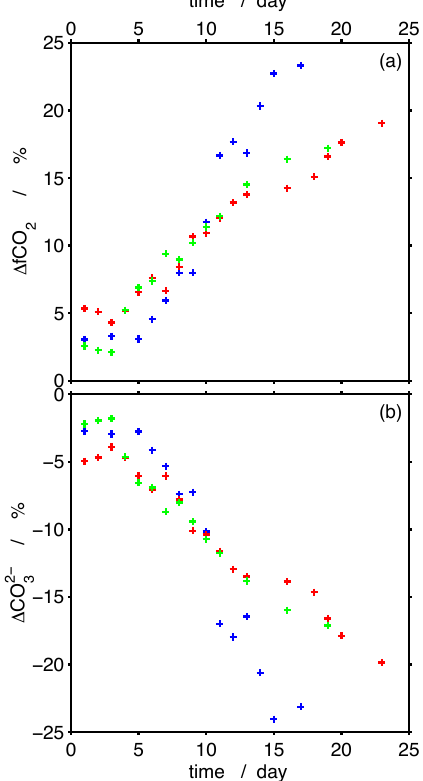
Fig. 1. Time course development of nitrate (mmolm − 3 ; a ) and DOC (mmolm − 3 ; b ) concentrations during three phytoplankton culture experiments. Blue: Prorocentrum minimum (Dinoflagel- late), red: Skeletonema costatum (Diatom), green: Chaetoceros curvisetus (Diatom).